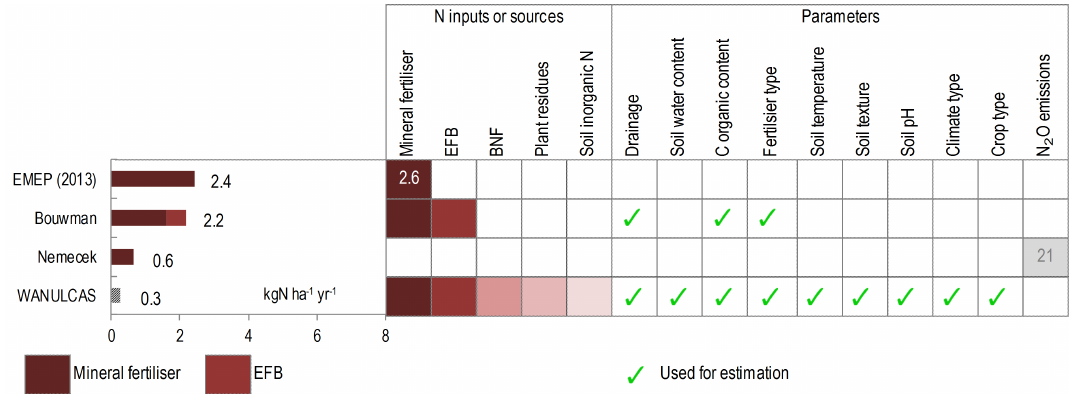
Figure 8. Comparison of annual average losses through NO x emissions, estimated by four sub-models. The average estimate was 1.4kg Nha − 1 yr − 1 , ranging from 0.3 to 2.4kg Nha − 1 yr − 1 . For Nemecek-2007, all sources are considered in one calculation. The ta- ble shows the N inputs and parameters used by the sub-models, and emission factors for linear relationships. Emission factors are in % of N inputs. EFB: empty fruit bunches, i.e. organic